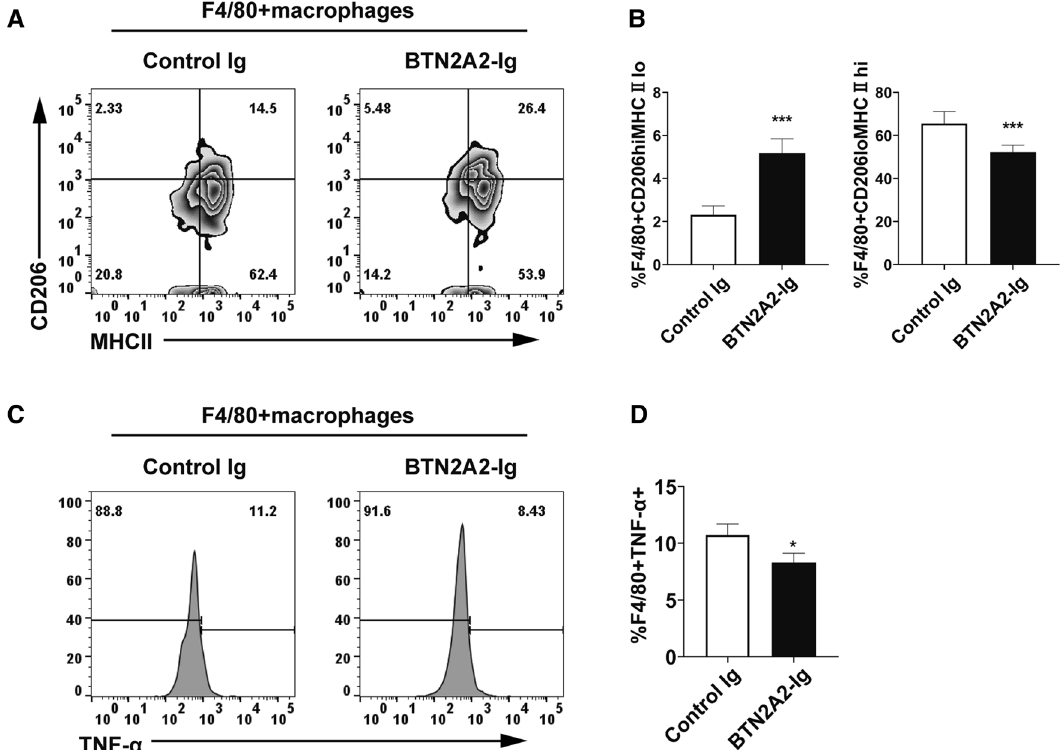
Figure 7. BTN2A2-Ig reduces M1 macrophages but increase M2 macrophages in vivo. Splenocytes from CIA mice treated with BTN2A2-Ig or control Ig as in Fig. 5. Cells were analyzed for ( A , B ) the percentages of F4/80 + CD206 hi MHCII lo M2 and F4/80 + CD206 lo MHCII hi M1, as well as ( C , D ) the percentages of TNF-α producing F4/80 + macrophages by flow cytometry. Data are shown as mean ± SD from one out of 3 independent experiments with similar results. (n = 6 each experiment each group) **P < 0.01, ***P < 0.001 compared with control Ig-treated